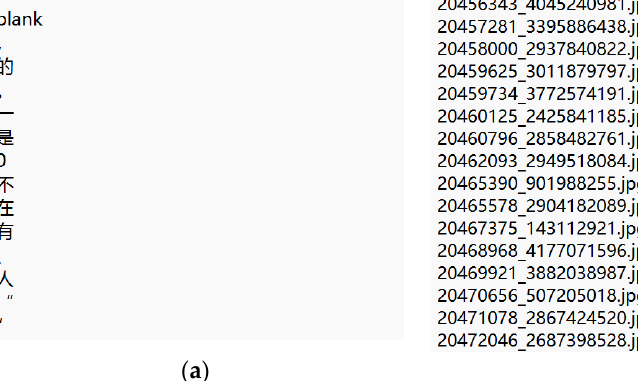
Figure 10. Data for CRNN training: ( a ) dictionary of characters and ( b ) index corresponding to image.